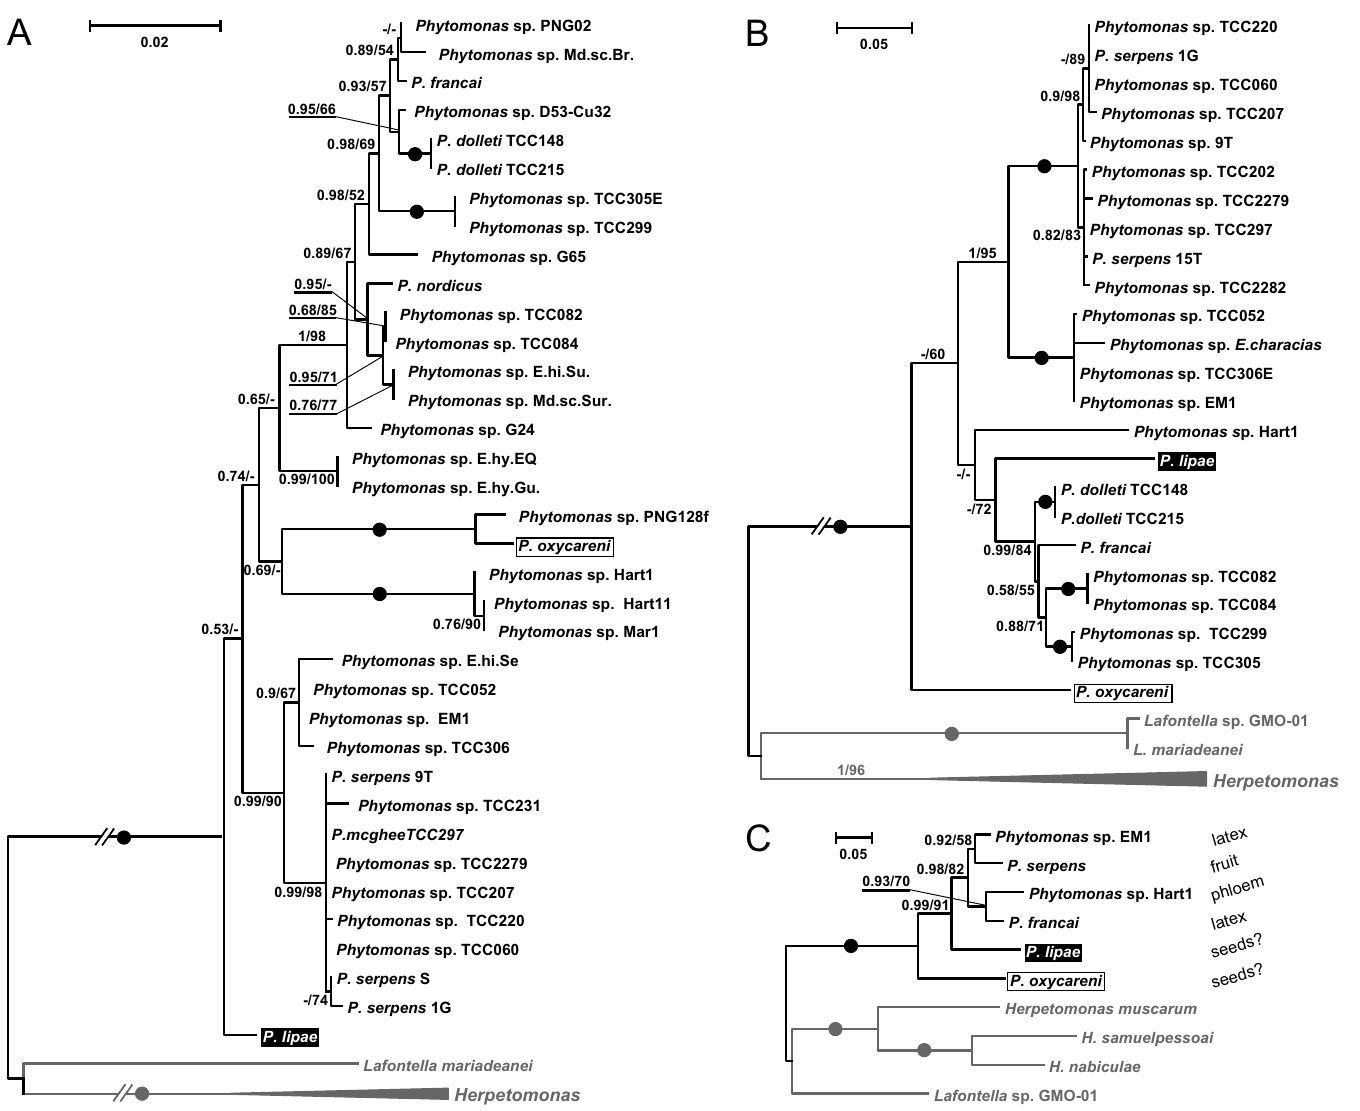
Fig 2. Maximum likelihood phylogenetic trees reconstructed using different molecular markers. A , SSU rRNA; B , gGAPDH ; C , HSP83. Numbers at nodes indicate posterior probability and bootstrap percentage, respectively. Values less than 0.5 and 50% are replaced with dashes. Nodes having 1.0 posterior probability, 100% bootstrap support are marked with black circles. Double-crossed branches are at 50% of their original lengths. The trees are rooted with the sequences of Herpetomonas and Lafontella spp . (shown in grey). The scale bar represents number of substitutions per site. Phytomonas lipae is highlighted and P . oxycareni is boxed. The known/ supposed parasitized plant host organs and tissues are indicated in C